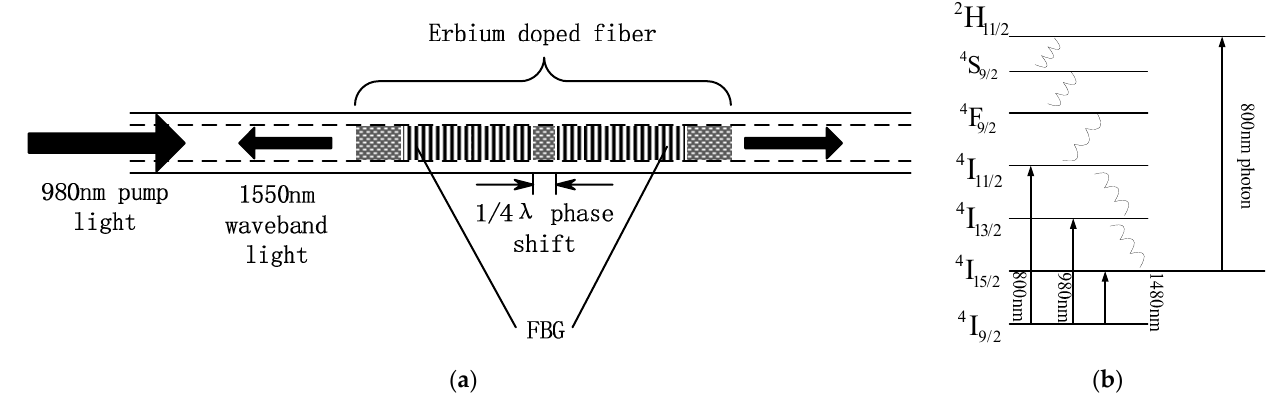
+ . Figure 1. ( a ) Configuration of DFB fiber laser ( b ) The energy level of the Er 3+ .